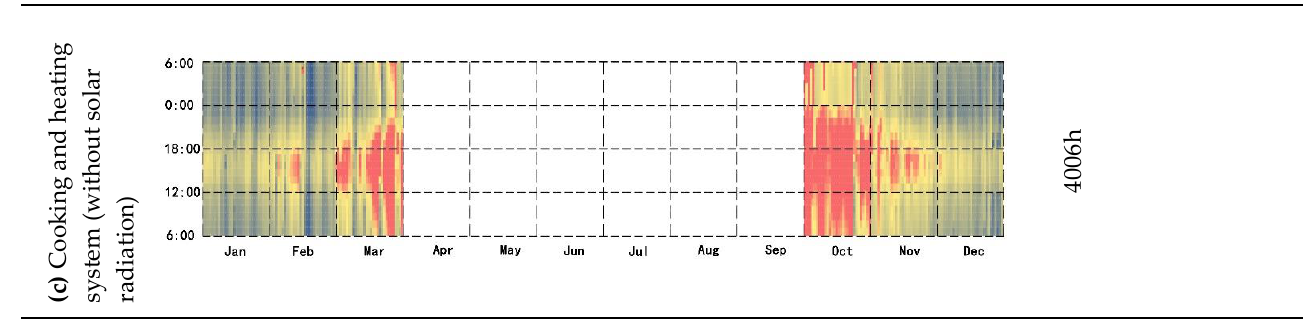
Figure 15. ( a ) The time when the average annual temperature of natural heating is lower than 18 °C; ( b ) Annual time when using cooking heating with solar radiation when the average temperature is below 18 °C; ( c ) Annual time when using cooking heating without solar radiation when the average temperature is below 18 °C.